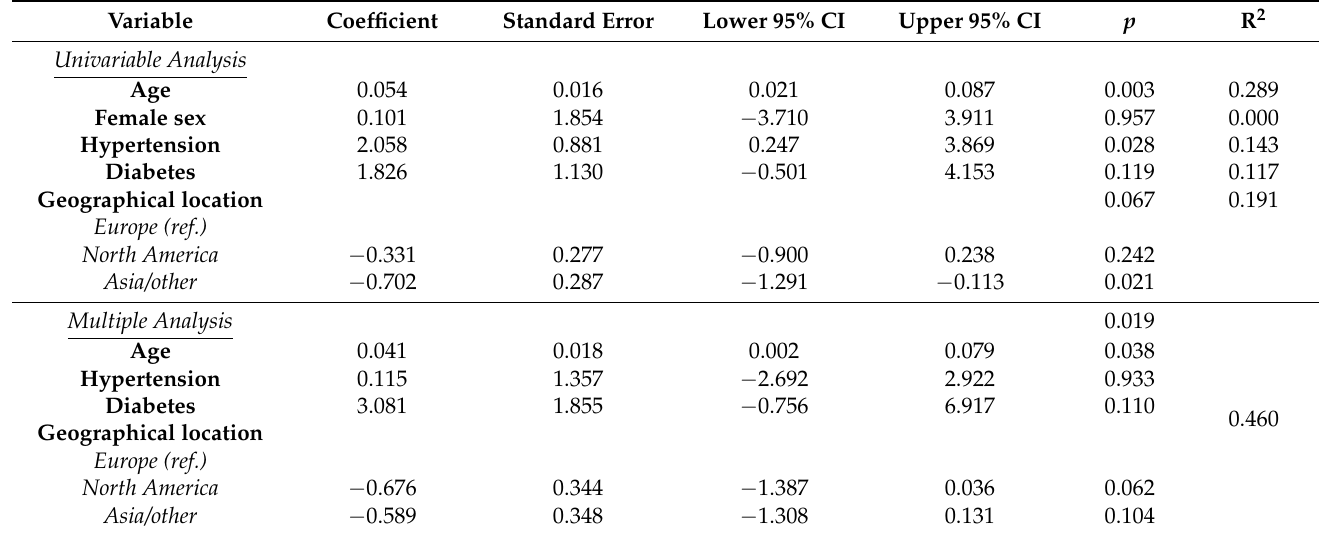
Table 2. Univariable and multiple meta-regression * analysis for AF prevalence.